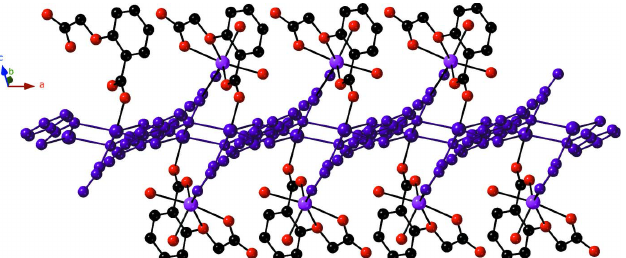
Figure 2 Exobidentate bridging mode of the cmb-A ligand.